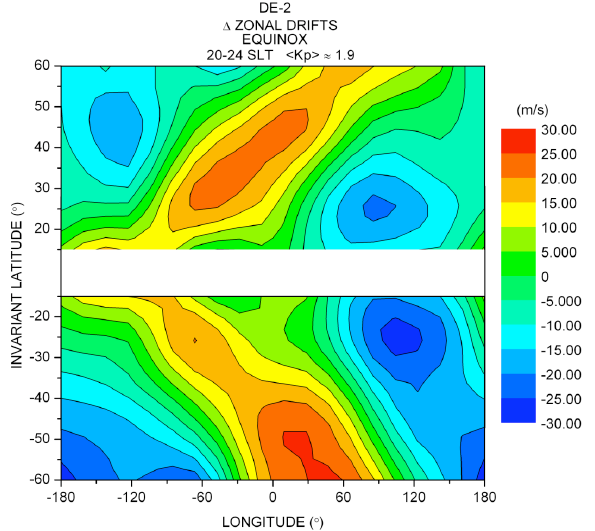
Figure 5 drifts (positive eastward) obtained by averaging the northern and southern hemisphere quiet-time relative drifts (upper panel). Lati- tudinal and longitudinal variations of the zonal drift velocities ob- tained by adding the relative drifts shown in the upper panel and the longitudinally averaged values at 22.5 LT (lower